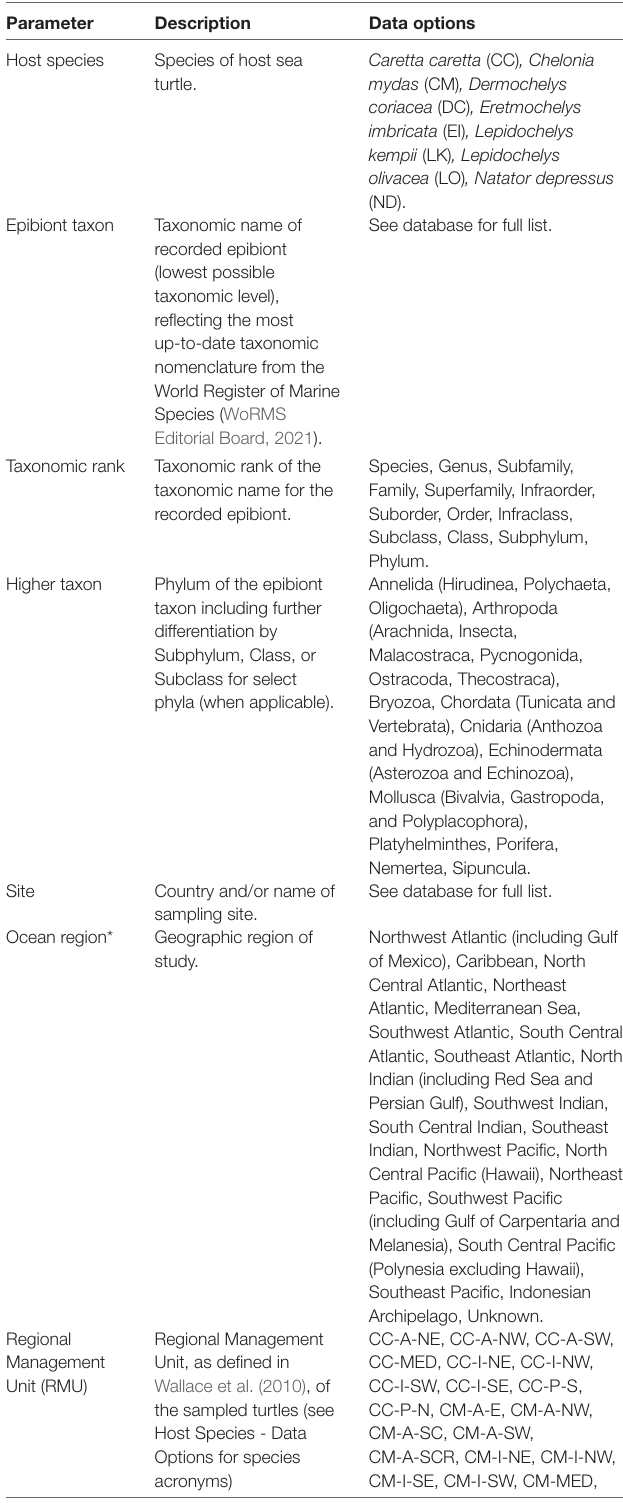
TABLE 1 | Data parameters and descriptions extracted for each sea turtle-epibiont interaction identified during an exhaustive review of published articles and gray literature (i.e., government reports, theses and dissertations, and conference presentations), including possible data options for each category.